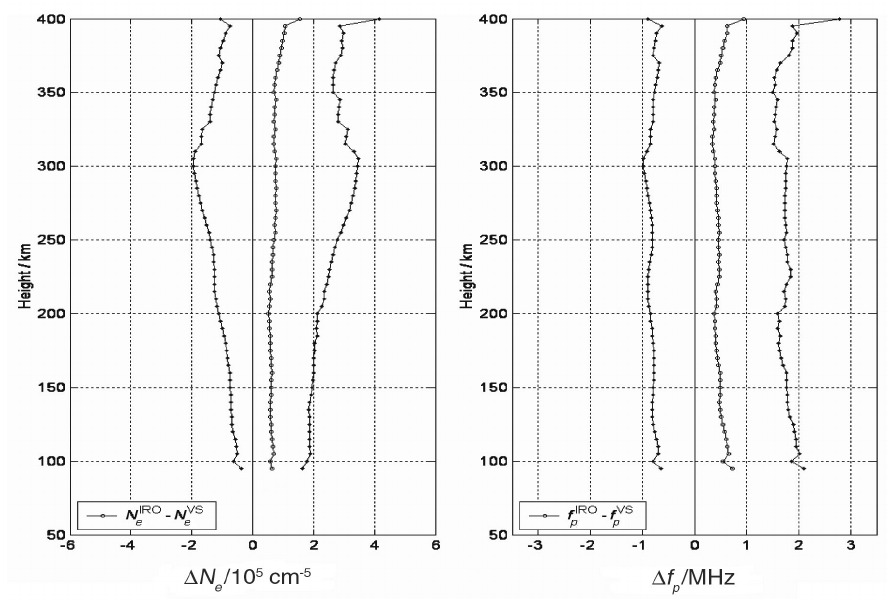
Fig. 7.4. Statistical comparison of IRO and coinciding vertical sounding derived EDPs (474 profiles, Athens, Dourbes, Juliusruh, Rome, Tortosa, 01/02-03/03). Left panel: electron density N e ; right panel: plasma frequency f p